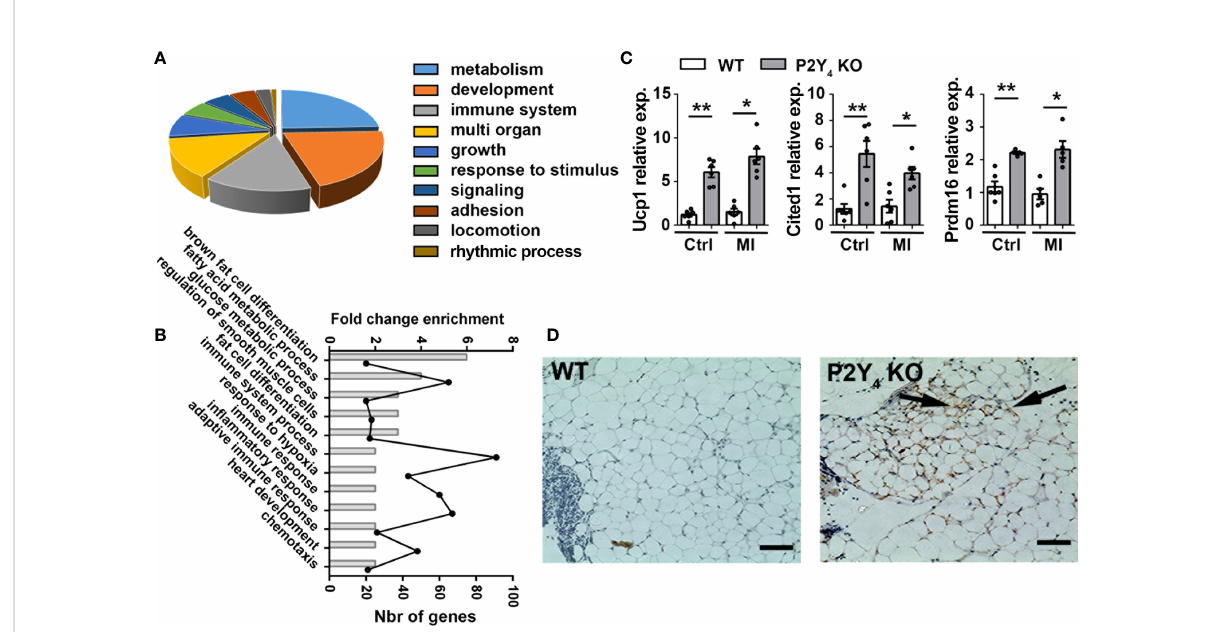
FIGURE 1 Loss of mouse P2Y 4 induces beiging of pericardial adipose tissue. (A) Representation of the biological processes related to the genes differentially expressed between PAT of P2Y 4 KO and WT ischemic mice (24h post-MI) in RNA-sequencing experiments. (B) Selection of biological processes revealed as enriched for a differentially expressed number of genes (Nbr of genes) between PAT RNA of P2Y 4 KO and WT ischemic mice, after a Gene Ontology enrichment analyses performed with DAVID software. (C) qPCR quanti fi cation of Ucp1, Cited1 and Prdm16 mRNAs in PAT of P2Y 4 KO and WT control (Ctrl) mice or 24h after LAD ligation (myocardial infarction (MI)), normalized to Rpl32 housekeeping gene (n = 6). (D) UCP1 staining performed by immunohistochemistry on paraf fi n ‐ embedded sections of PAT of WT and P2Y 4 KO ischemic mice (24h post-MI) and counterstained with hematoxylin/eosin (scale bar = 50 m m). Examples of regions positive for UCP1 staining are indicated by black arrows and images were taken at original magni fi cation 100x. Data represent mean ± SEM. *p < 0.05; **p <